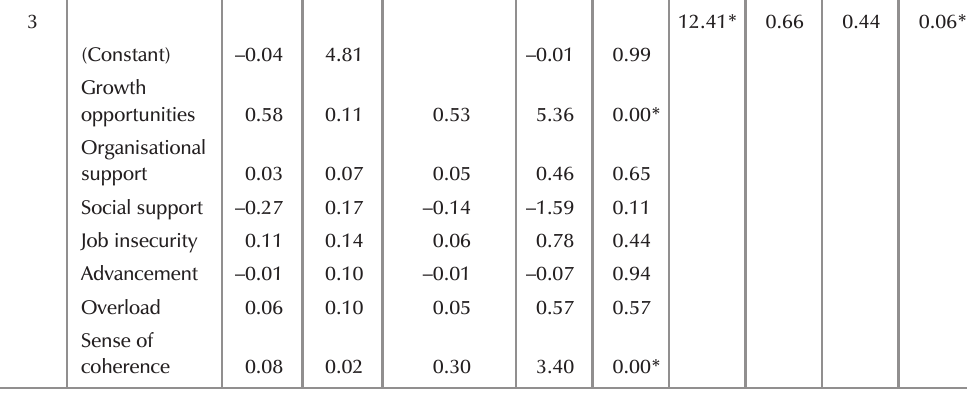
Table 6 shows that job resources predicted 38 per cent of the variance in dedication. However, only the regression coefficient of growth opportunities was statistically significant. No statistically significant increase was reported in the total variance explained when overload was added to the model. When sense of coherence was added to the model, a statistically significant increase in R 2 was again observed ( ∆ R 2 = 6 per cent). Therefore, dedication is best predicted by growth opportunities in the job (variety, learning opportunities and autonomy), and a strong sense of